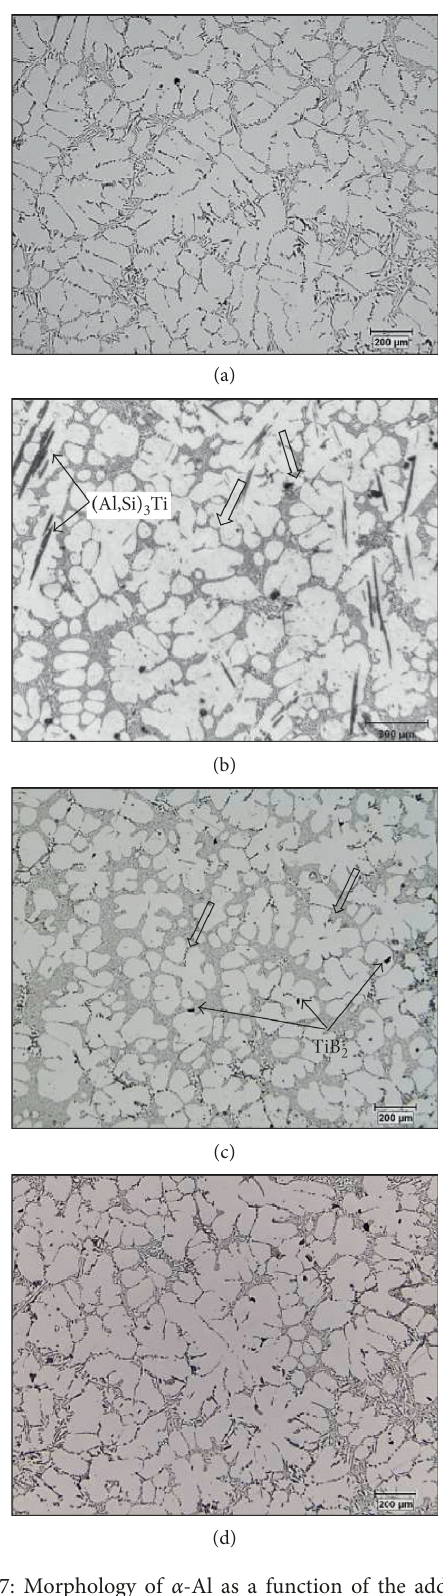
Figure 7: Morphology of α -Al as a function of the added grain refiner: (a) no melt treatment, (b) localization of (Al,Si) 3 Ti phase particles within the α -Al dendrites in the A356.2 alloy treated with 0.3%Ti and poured at 750 ° C, and (c) 0.1%Ti, 200 ppm B. Note the rosette morphology of the α -Al dendrites (open arrows). (d)